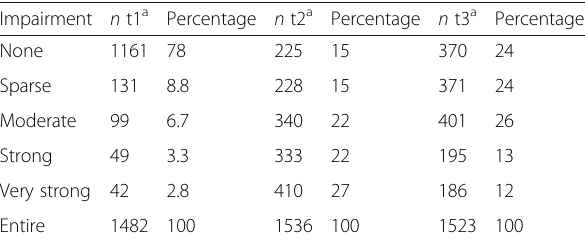
Table 4 Typical chronological process of impairments using the example of appearance